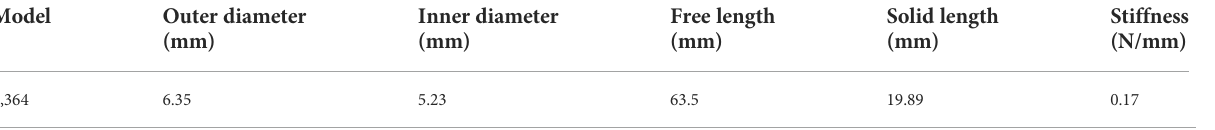
TABLE 2 Parameters of the selected commercialized spring.